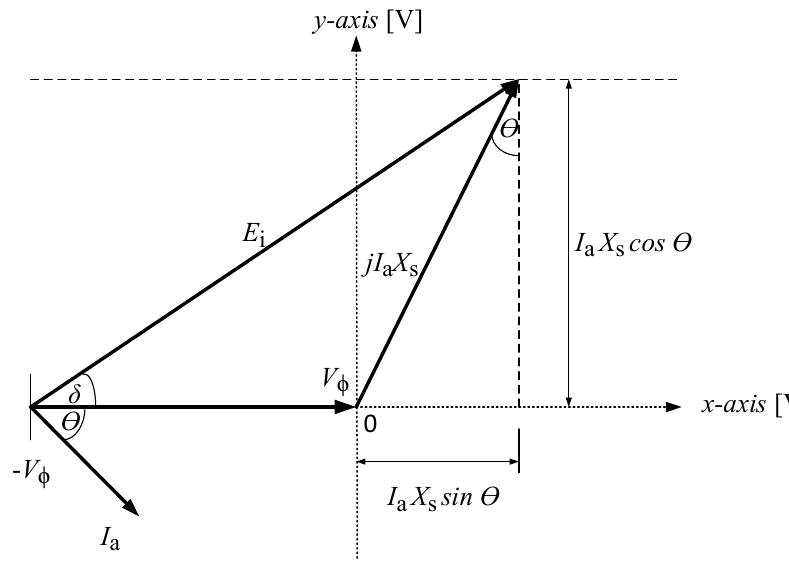
Figure 2. Phasor plot diagram in the x and y axis.